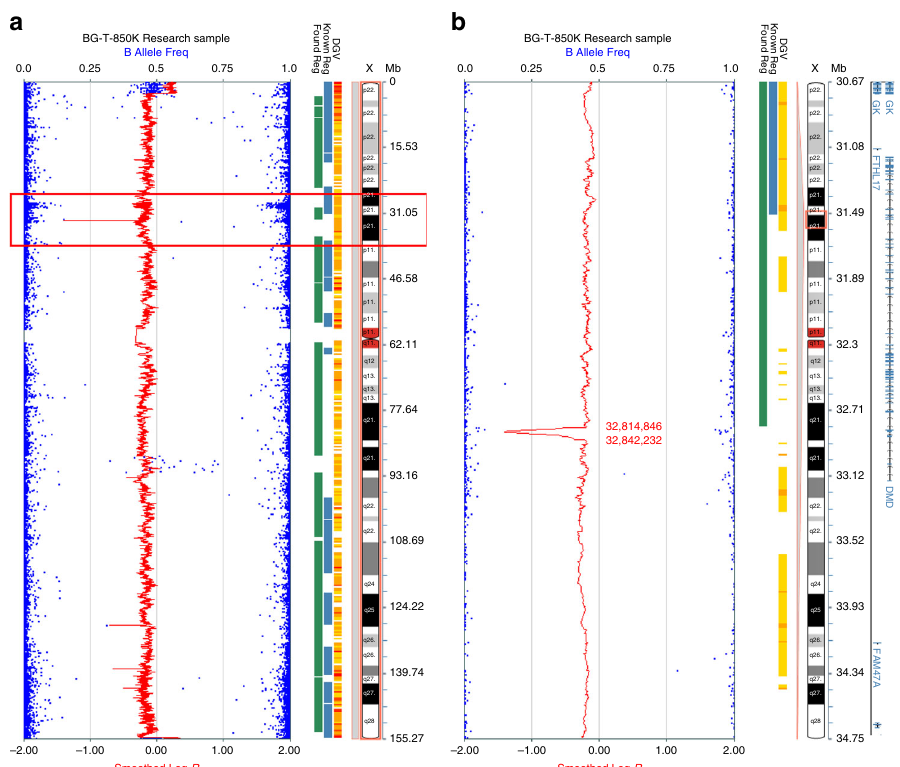
Fig. 2 Detection of a 27 kb deletion in DMD . High density SNP array (850k chip) detected a 27 kb deletion of the DMD gene in an ONB from a male patient (ENBBG-T, Table 1). The panel on the left ( a ) shows the array pro fi le of the entire chromosome X, with indicated deletion in Xp21.1. The panel on the right ( b ) focuses on the region of Xp21.1 containing the DMD gene. The deletion is within the DMD gene, from genomic position 32,814,846 – 32,842,232 detectable structural abnormality in the X chromosomes. Inter- estingly, this patient did have a homozygous deletion in LAMA2 , the gene encoding the alpha 2 chain of laminin (Supplementary Figure 2).